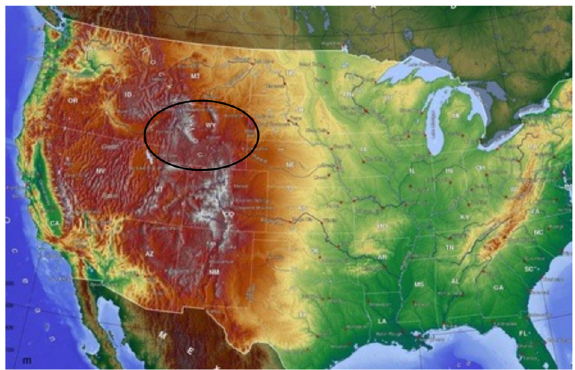
Fig. 2 Topography of Wyoming, in relation to other states, the darker areas highlight the mountainous